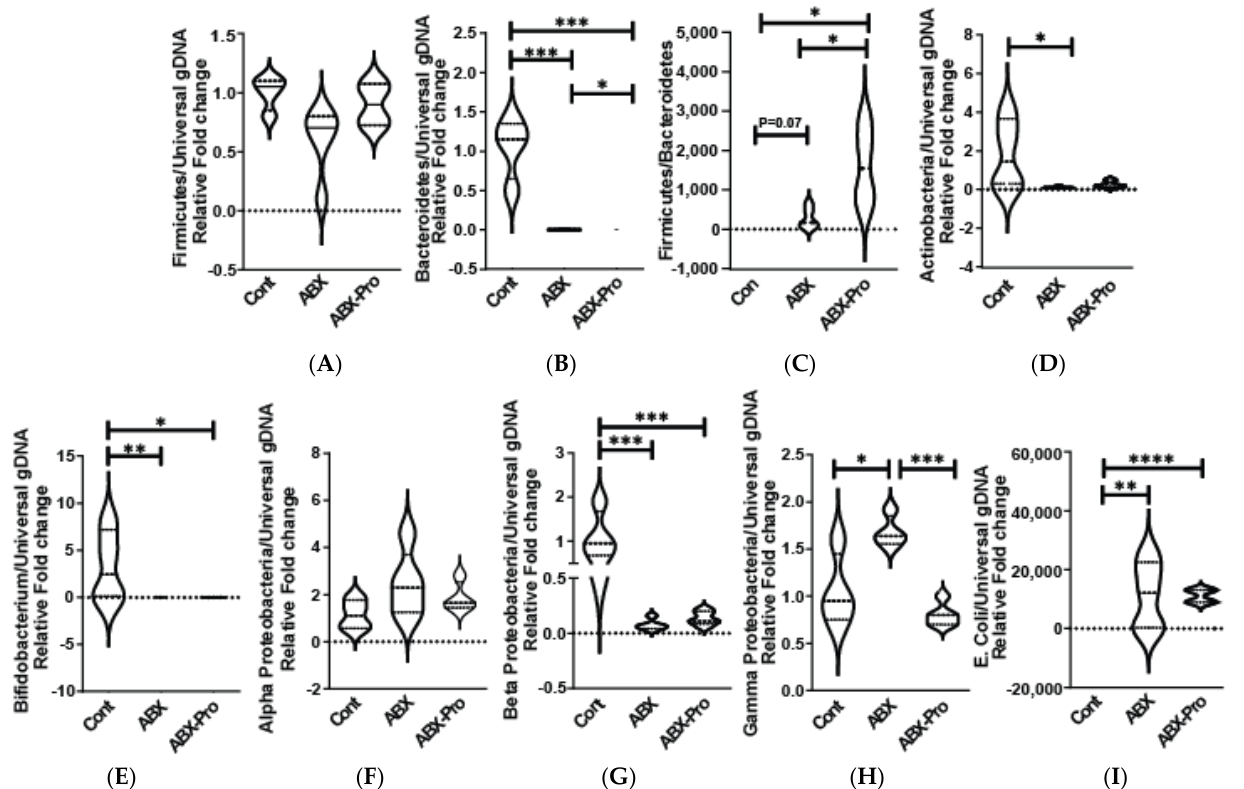
Figure 3. Cecal Microbiome: Mice were treated as described in Figure 1. At euthanasia, cecum was dissected and contents were collected, genomic DNA (gDNA) was isolated, and qRT-PCR was utilized to detect the relative abundance of ( A ) Firmicutes and ( B ) Bacteroidetes. ( C ) The ratio of the relative abundance of Firmicutes to Bacteroidetes was calculated. Further qRT-PCR was preformed to determine the relative abundance of ( D ) Actinobacteria, ( E ) Bifidobacterium, ( F ) Alphaproteobacteria ( G ) Betaproteobacteria, ( H ) Gammaproteobacteria, and ( I ) E. coli . Values represent mean ± standard error of the mean. * p < 0.05, ** p < 0.01, *** p < 0.001, **** p < 0.0001.